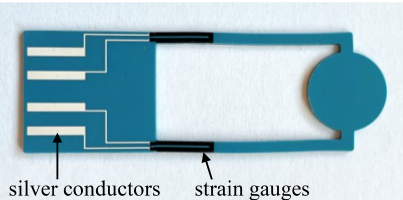
Figure 12. Three-layer sensor chip with screen-printed strain gauges and silver conductors.